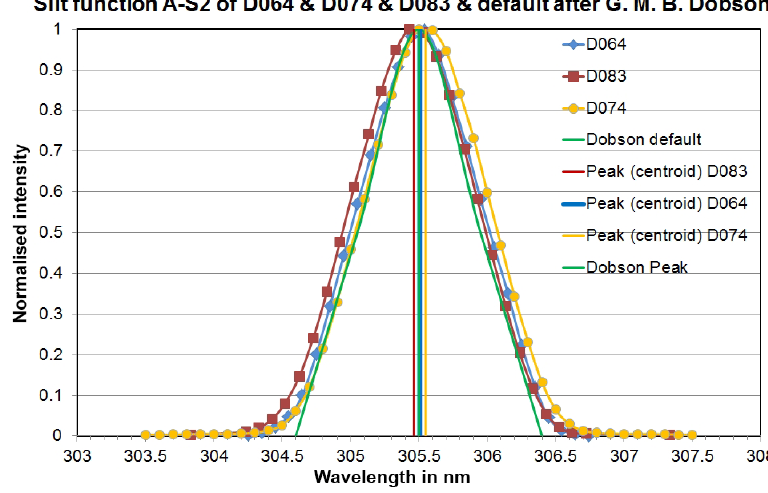
Figure 5. Slit functions at the short wavelength of wavelength pair A (A-S2) of all three reference Dobsons.